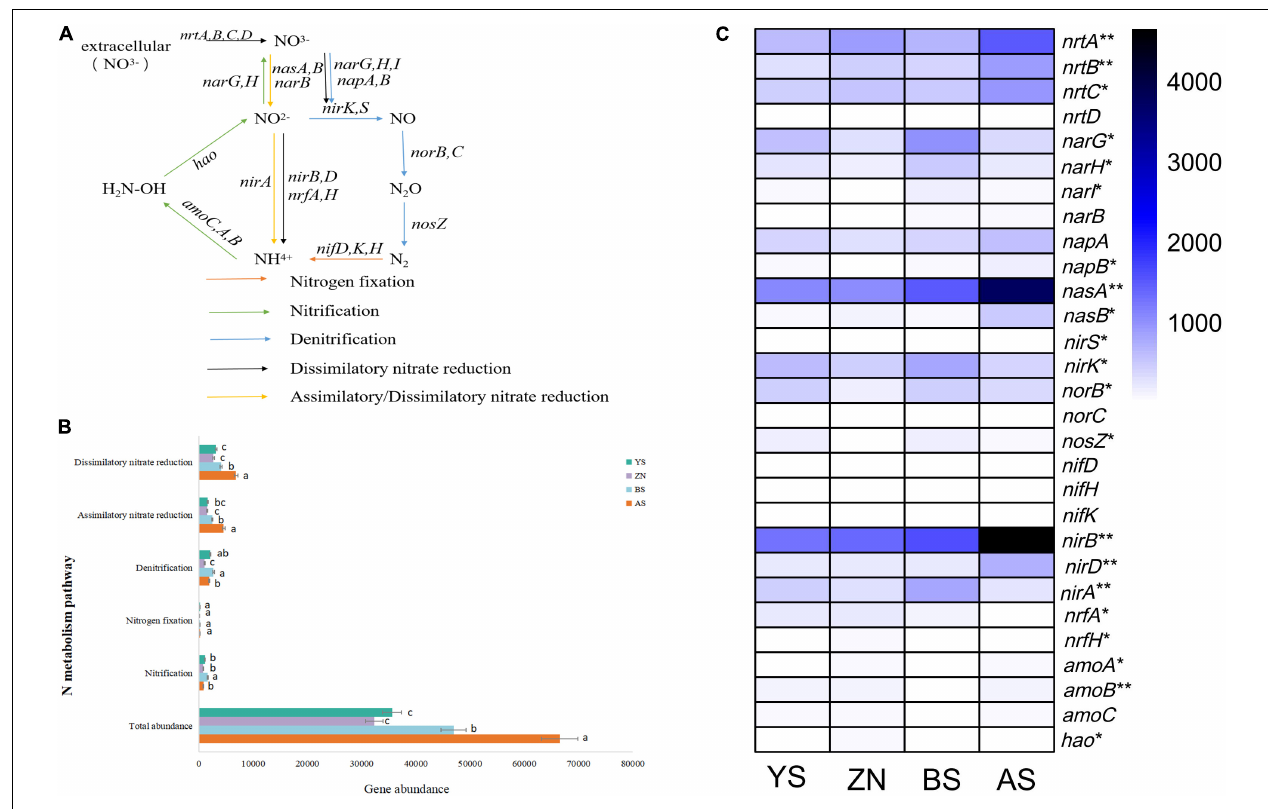
FIGURE 2 | N-metabolism pathways and their frequencies. (A) N pathways considered in this study. Arrows of different colors represent different pathways, and the words above the arrows are gene names. (B) Abundance of different N-metabolism pathways in Robinia pseudoacacia rhizosphere soils in four counties. Different letters on the right of the bars indicate significant differences between treatments, according to Fisher’s protected LSD ( P < 0.05). (C) Abundance of genes related to core N-metabolism pathways. ** p < 0.01 and * p <